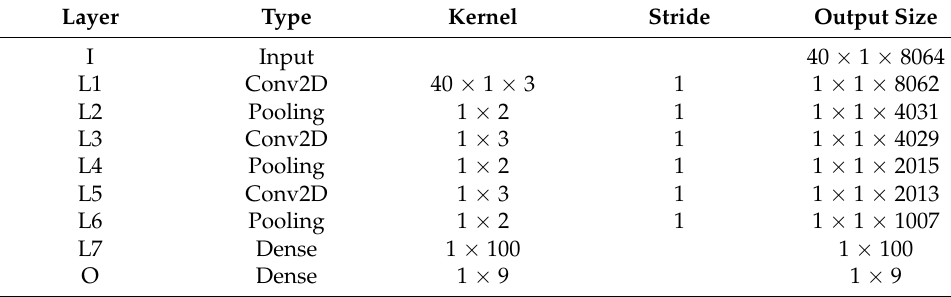
Table 3. Top-channel network structure